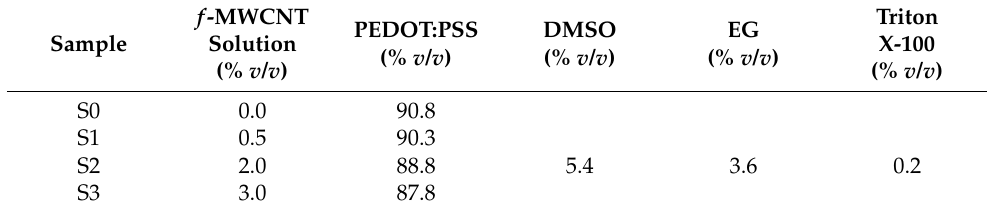
Table 1. Concentration of each chemicals for preparing the solutions.